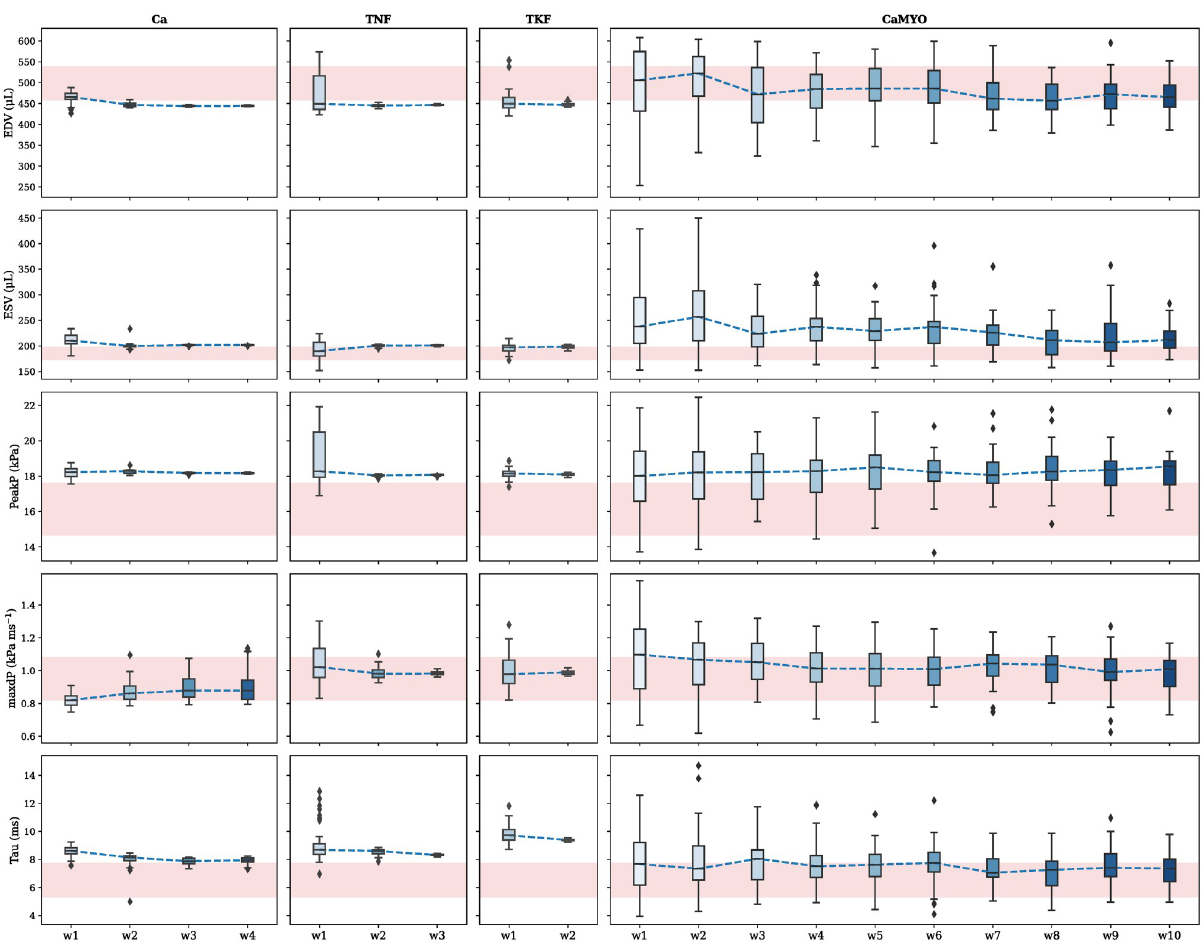
Fig 6. History matching waves progression. At each wave, 128 points are simulated from the current non-implausible parameter region and the features’ values from the converging simulations are plotted as box plots coloured in blue variants for different consecutive waves. The median trend of these distributions is represented by a dashed blue line. Mean ± 3 standard deviations target intervals are represented in light red-coloured shaded areas for each LV feature.